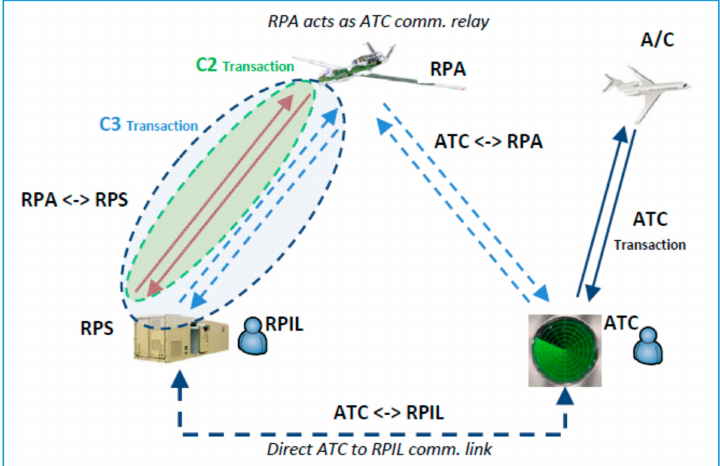
Figure 3. Schematic diagram of communications between a RPAS (RPA to RPS), a conventional aircraft, and ATC [36].